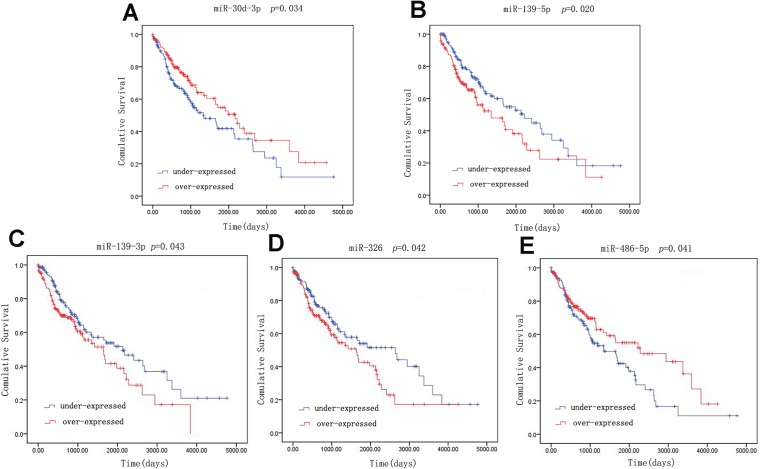
Kaplan–Meier survival curves for five miRNAs associated with overall survival.Horizontal axis: overall survival time, days; Vertical axis: survival function.